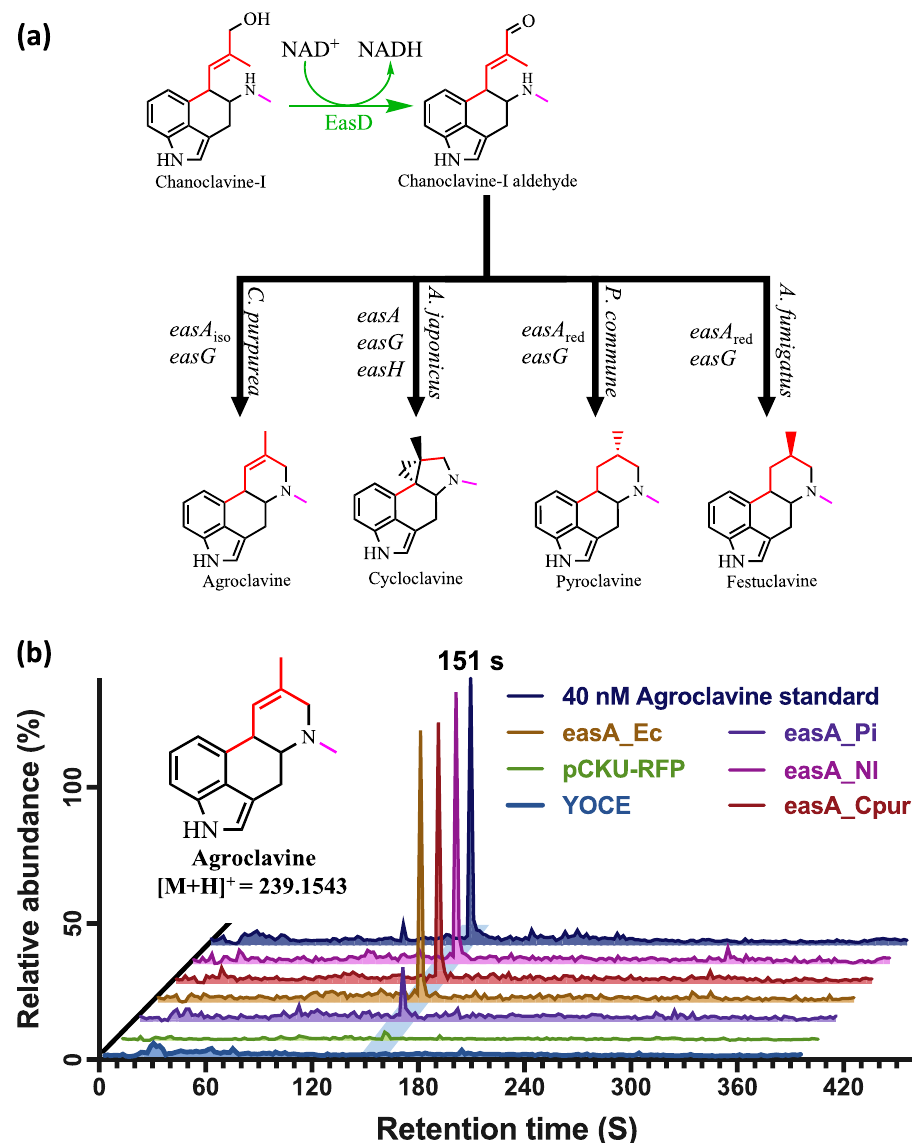
Fig. 3 Screening of EasA orthologues. a Reactions forming the ergoline D ring from chanoclavine-I. Different combinations of enzymes and isoforms (EasA, EasG, and EasH) control the divergence of the tetracyclic ergoclavine products formed at this branchpoint. Orthologues of EasA were screened with episomal plasmids in a strain containing genes for the early pathway enzymes dmaW , easF , easC , and easE integrated onto the yeast genome and regulated by the P tef2 , P gpm1 , P gal10 , and P gal1 promoters respectively. b LC-MS chromatograms of the screened EasA orthologues. All selected orthologues were